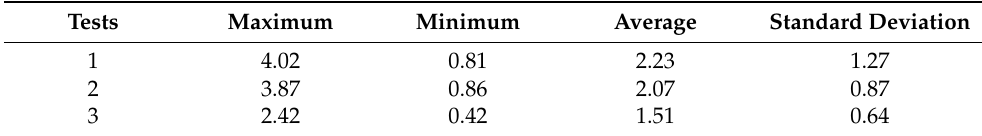
Table 2. Robot CD/(°). Table 2. Robot CD/( ◦ ).